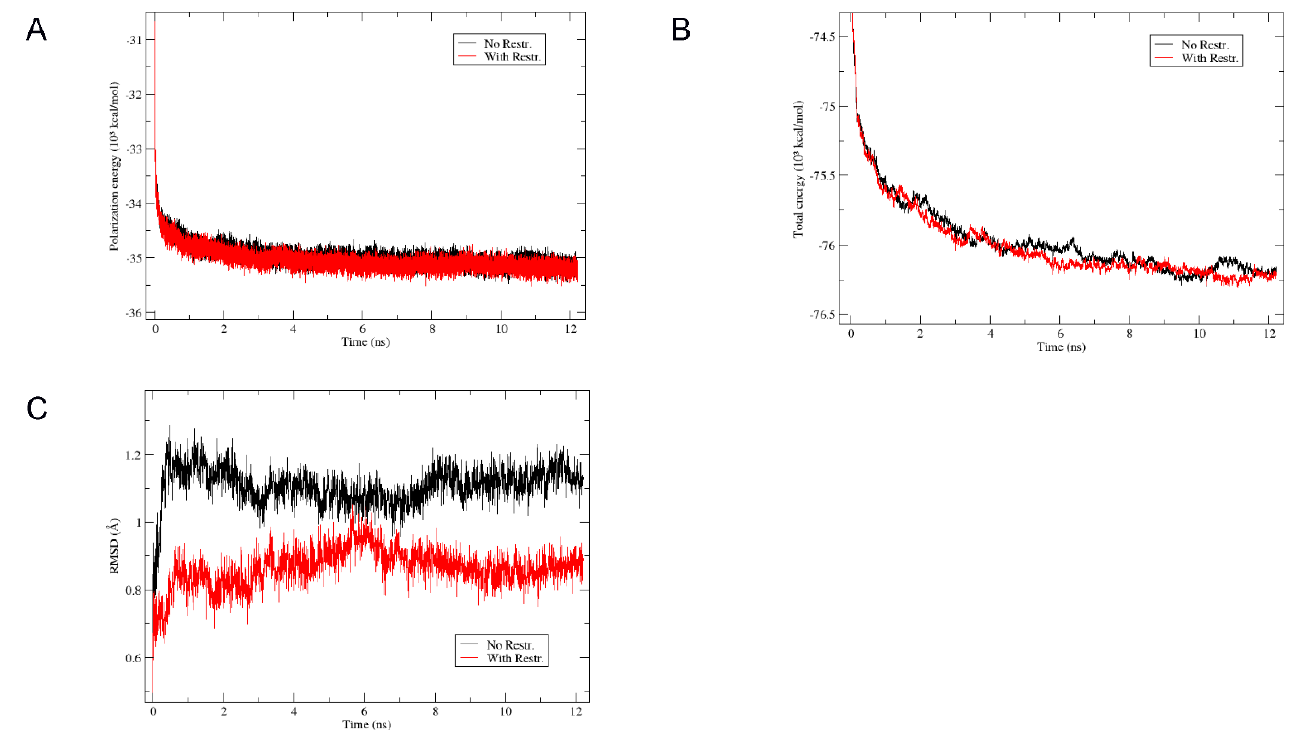
Figure 5. Evolution of ( A ) the polarization energy, ( B ) the total energy, and ( C ) the RMSD of backbone atoms during the 12 ns NPT MD simulation performed with the Amber program using the ff14SB force field without (“No Restr.”, black curve) or with (“With Restr.”, red curve) constraints on the initial P-U1 and P-U2 distances.